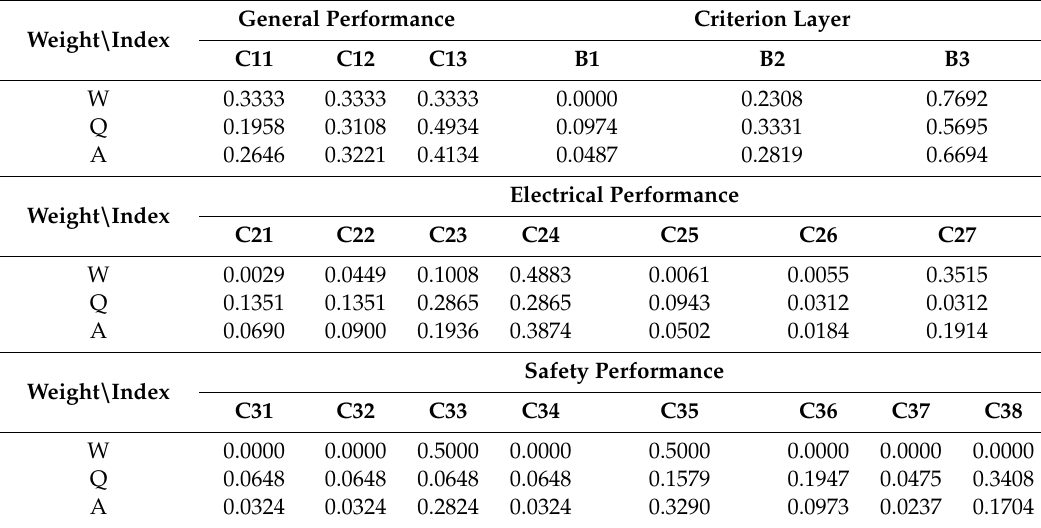
Table 9. Comprehensive weight of the indicators.